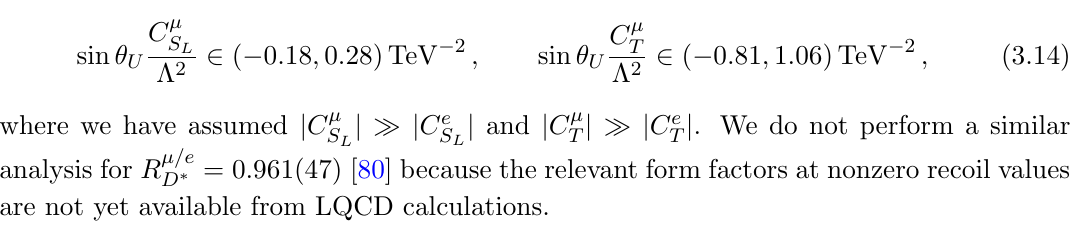
Figure 3 . Allowed regions by R D and R D (cid:3) in the plane C (cid:28) C (cid:28) sin (cid:18) U vs. C (cid:28) (right panel) are shown to 1, 2 and 3 (cid:27) accuracy in blue (darker to lighter). We S L S R accounted for the electroweak and QCD running from the NP scale (cid:3) where the hadronic parameters are computed, cf. ref. [48]. The black line shows the constraint from the B c -meson lifetime, which allows us to exclude the solutions with large values of explained in the